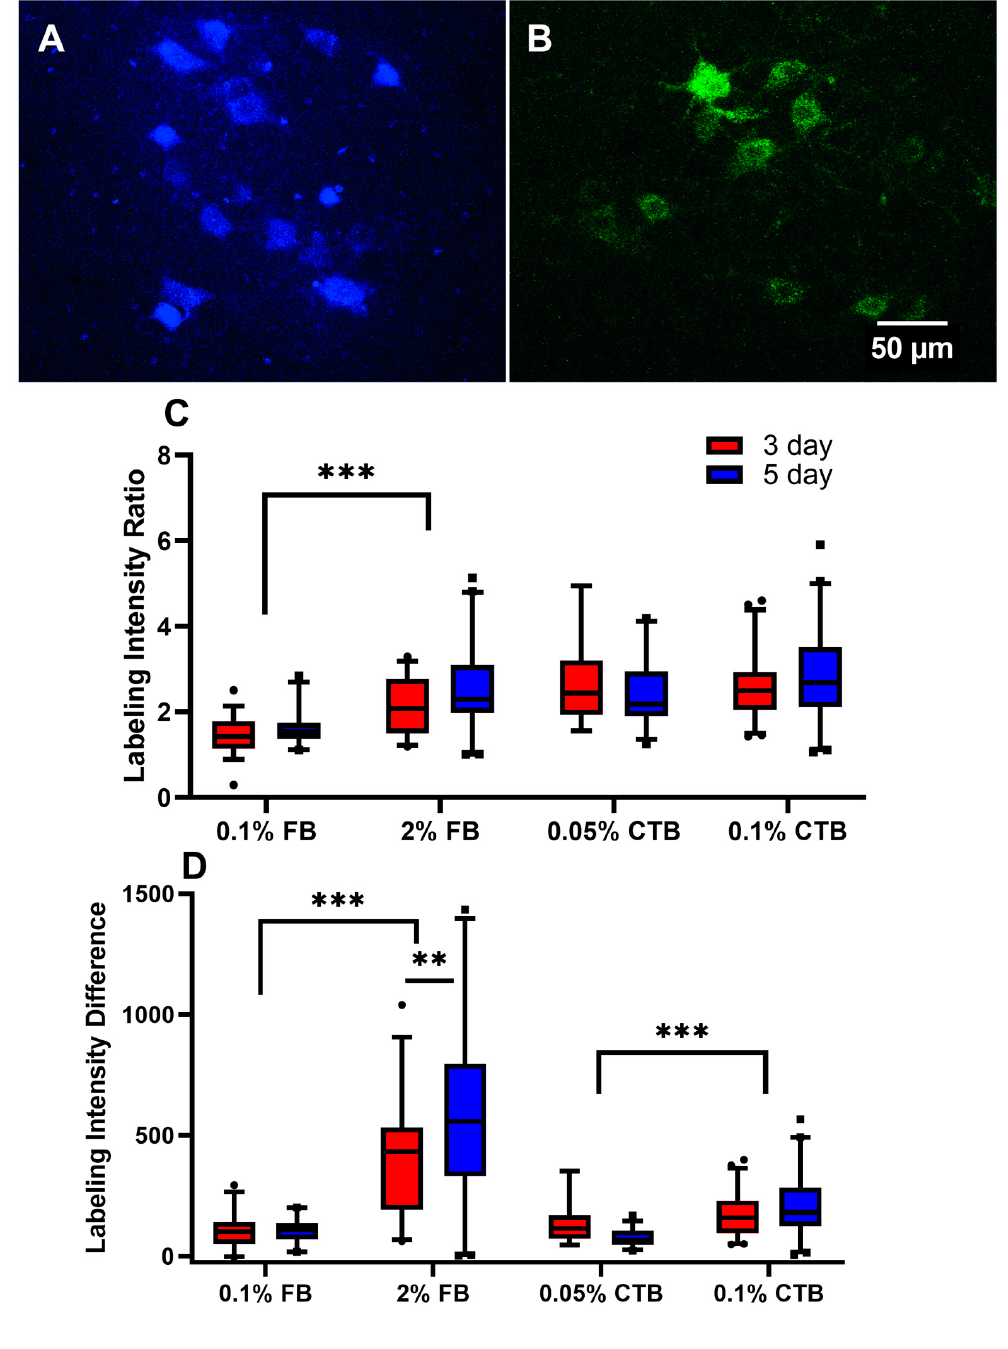
Figure 7. Neuronal label intensity ratio and difference among aged mice (25 months) tracer protocols. ( A ) An FB (2%, 5-day labeling duration protocol) image taken from the tissue of an old